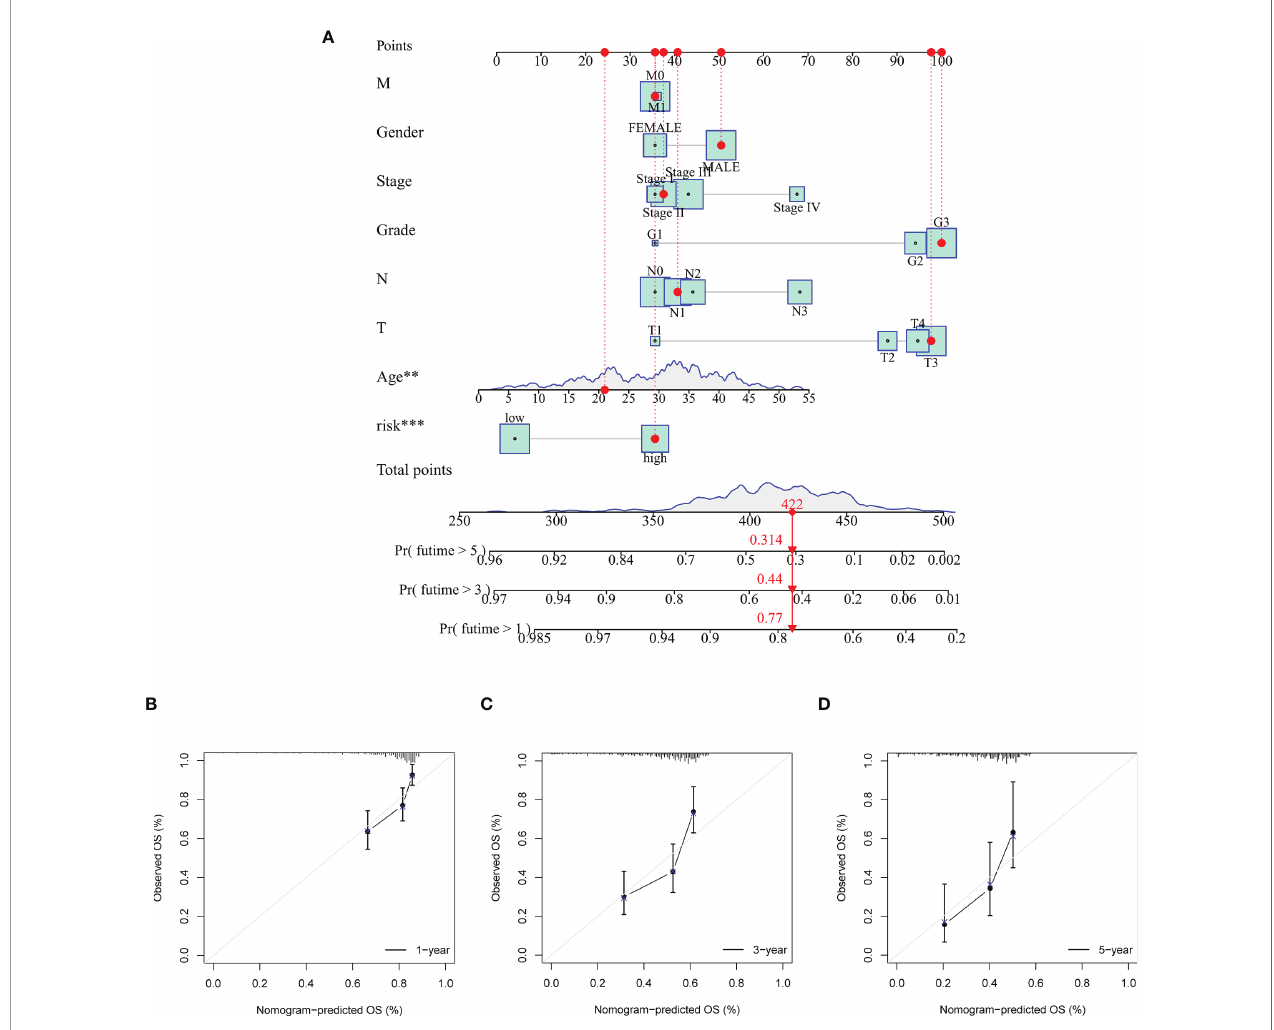
FIGURE 7 | Principal component analysis (PCA) to visualize gene expression patterns in the different groups. The groups de fi ned by all genes (A) , matrisomal- related genes (B) , matrisomal-related lncRNAs (C) , and risk score based on matrisomal-related lncRNAs (D) . ** p < 0.01, *** p <